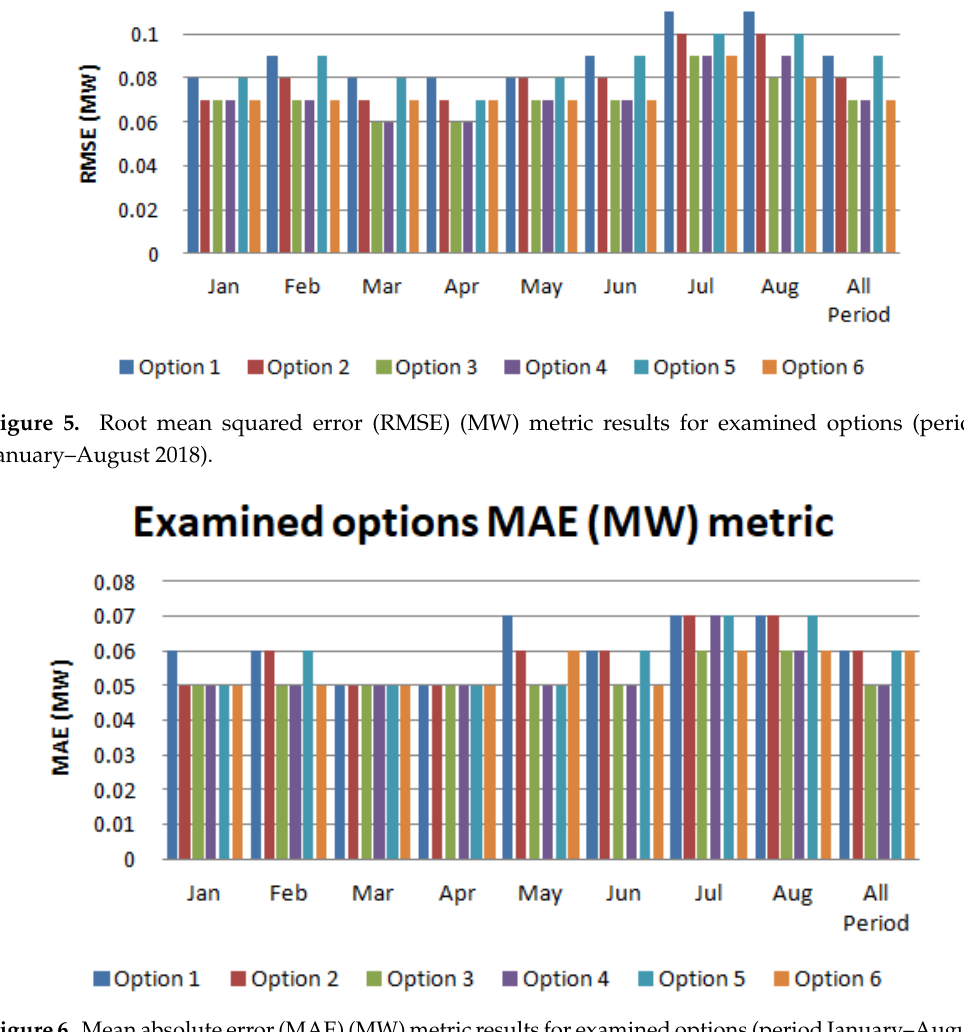
Figure 6. Mean absolute error (MAE) (MW) metric results for examined options (period January–August 2018).